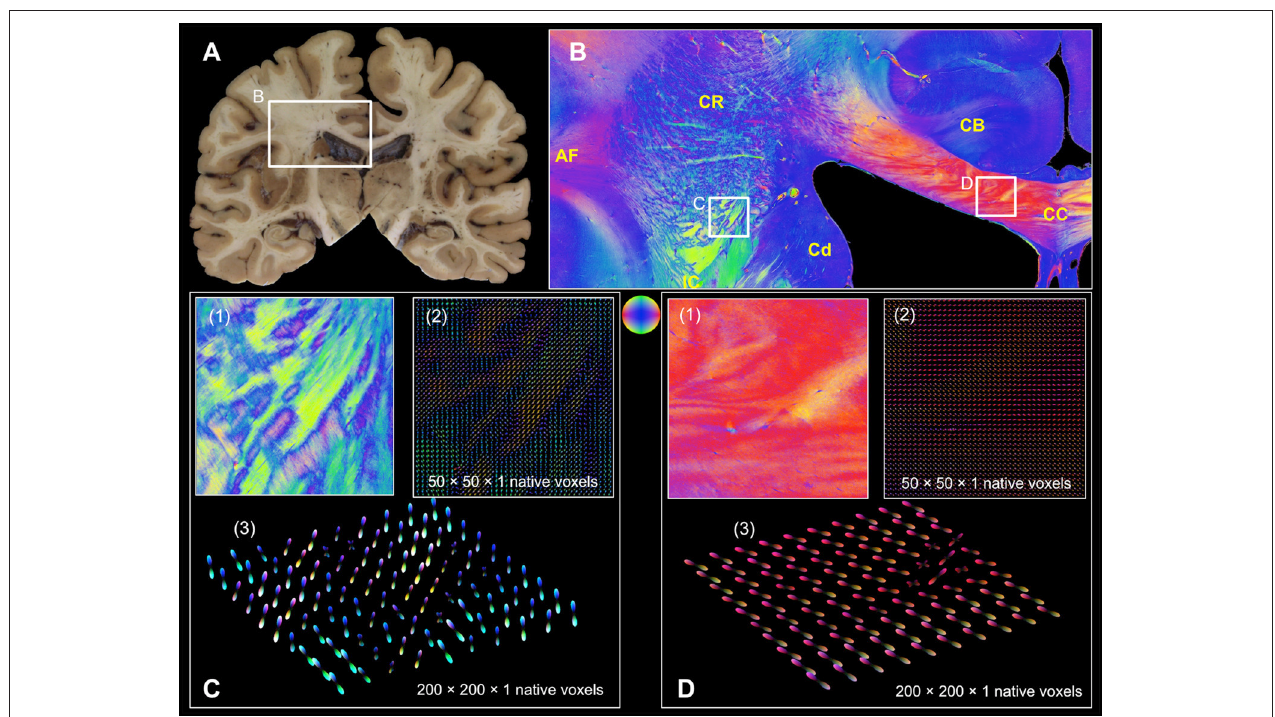
FIGURE 7 | Coronal section from the central human brain region. (A) Segmented blockface image acquired from the surface of the frozen human brain. (B) Fiber orientation map comprising arcuate fascicle (AF), cingulum bundle (CB), corpus callosum (CC), caudate nucleus (Cd), corona radiata (CR), internal capsule (IC). Fiber orientations are RGB color-coded (see sphere). The white rectangles indicate FOMs (C(1) and D(1)) that were transferred into pliODFs. (C) pliODF representations in the region of CR/IC with super-voxel dimensions of (2) 50 × 50 × 1 and (3) 200 × 200 × 1 native voxels (from different views). Patches of crossing fiber bundles are clearly visible in the FOM and the pliODF maps. (D) pliODF representations in the region of CC with super-voxel dimensions of (2) 50 × 50 × 1 and (3) 200 × 200 × 1 native voxels (from different views). Although a predominant fiber direction is observable, small wriggling fiber bundles cause local inhomogeneities along the